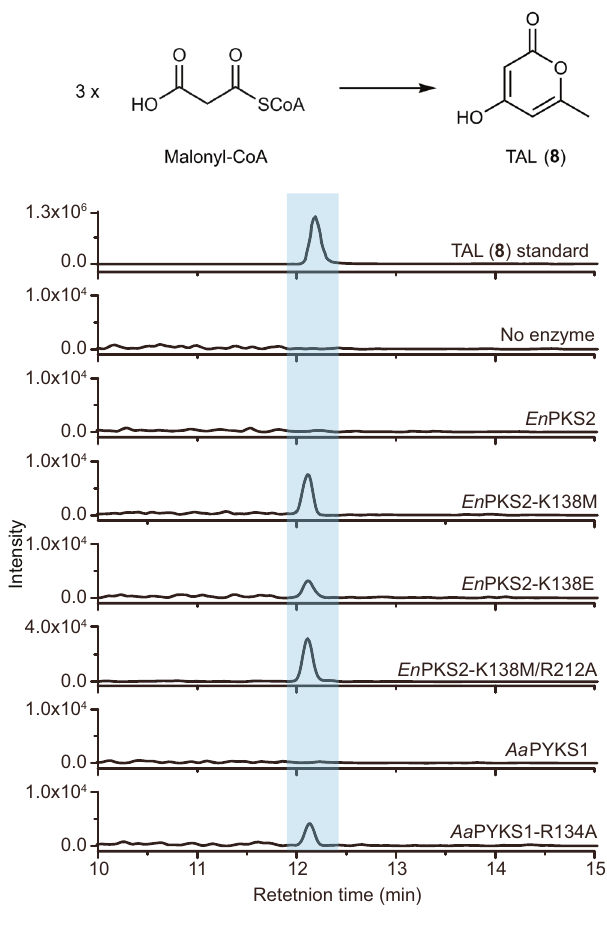
Fig. 4 | LC-MS chromatograms at [M+H] + =127.0390±0.001 of TAL ( 8 ) in enzymatic reactions using malonyl-CoA as substrate. A representative result of n =3 independent experiments is